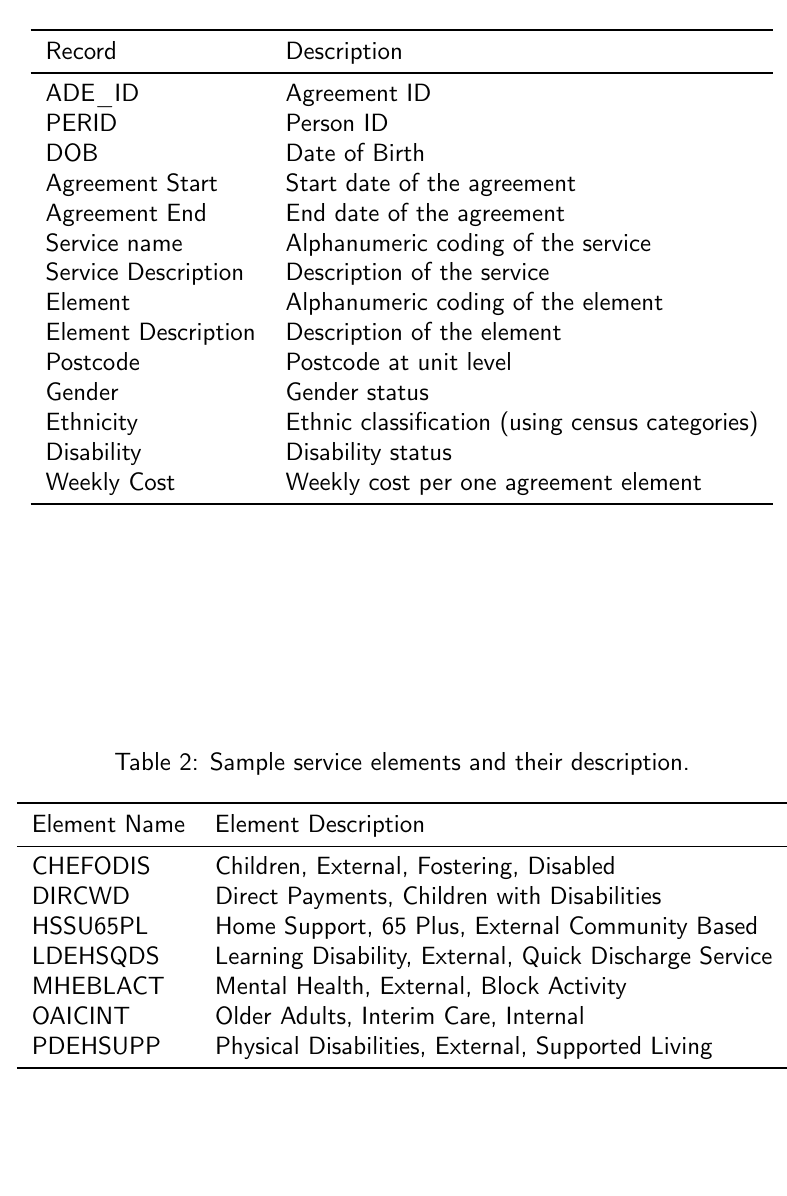
Table 1: Records comprising a Closed Agreement and their description; note, only 14 of 18 available records are used in this study. Free-text fields are also present and not listed below.